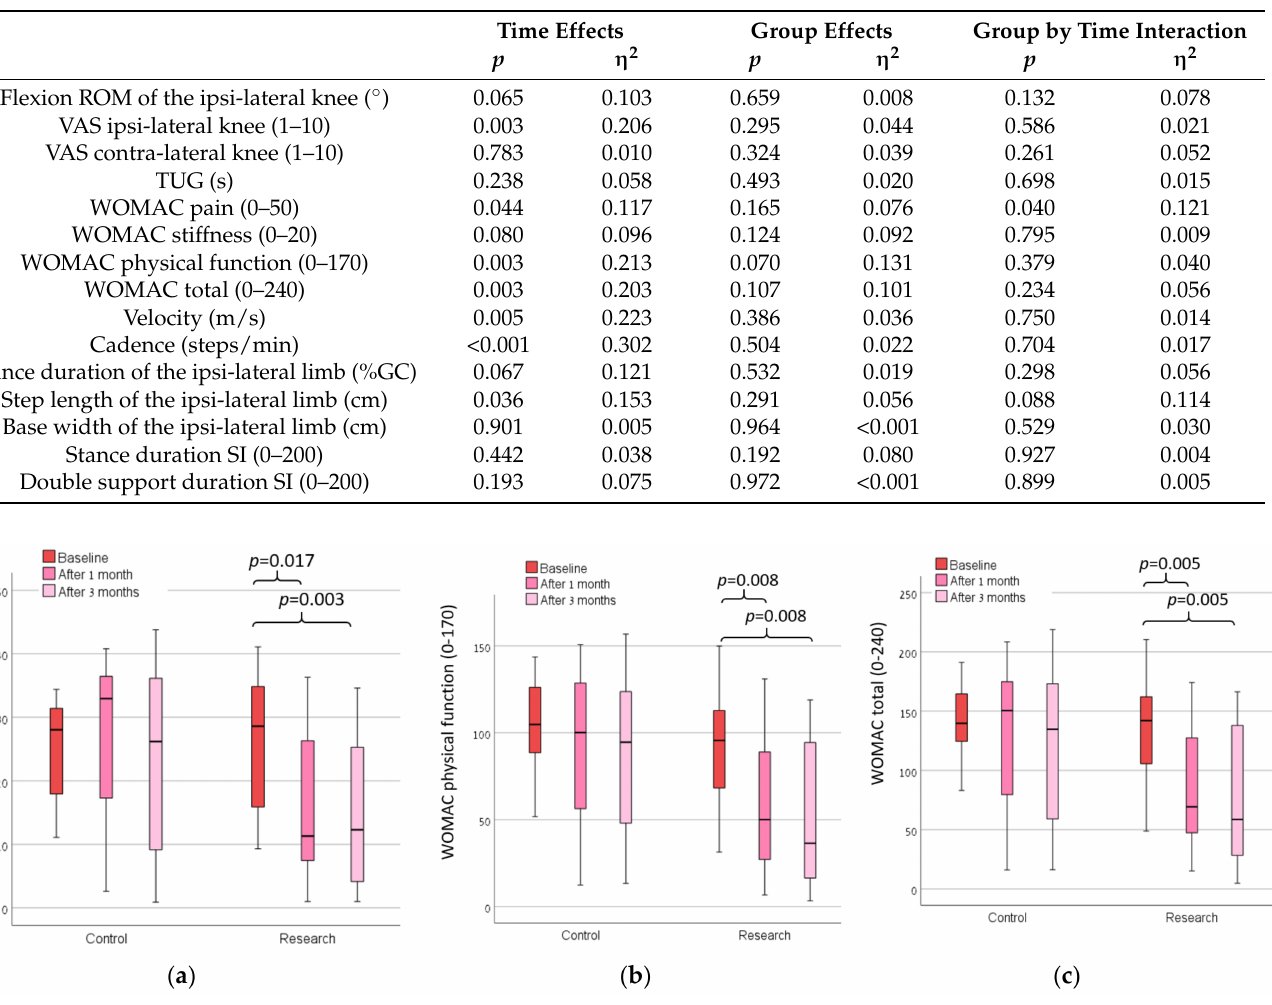
Table 2. Results of the repeated measures analysis of variance (ANOVA). Data are presented as F, p and effect size (partial η 2 ). Results of statistical significance are in bold. ROM = Range of Motion; VAS = Visual Analogue Scale; TUG = timed up and go; WOMAC = Western Ontario and McMaster Universities Arthritis Index; SI = Symmetry Index; GC = Gait Cycle.